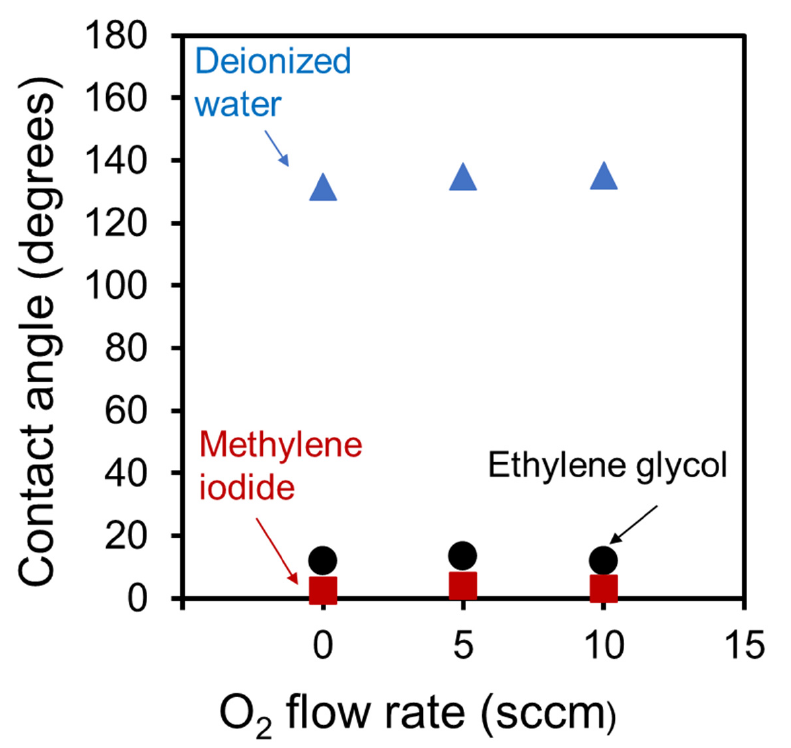
Figure 8. Contact angles for each droplet on the surfaces of CNWs grown at various oxygen flow rates.